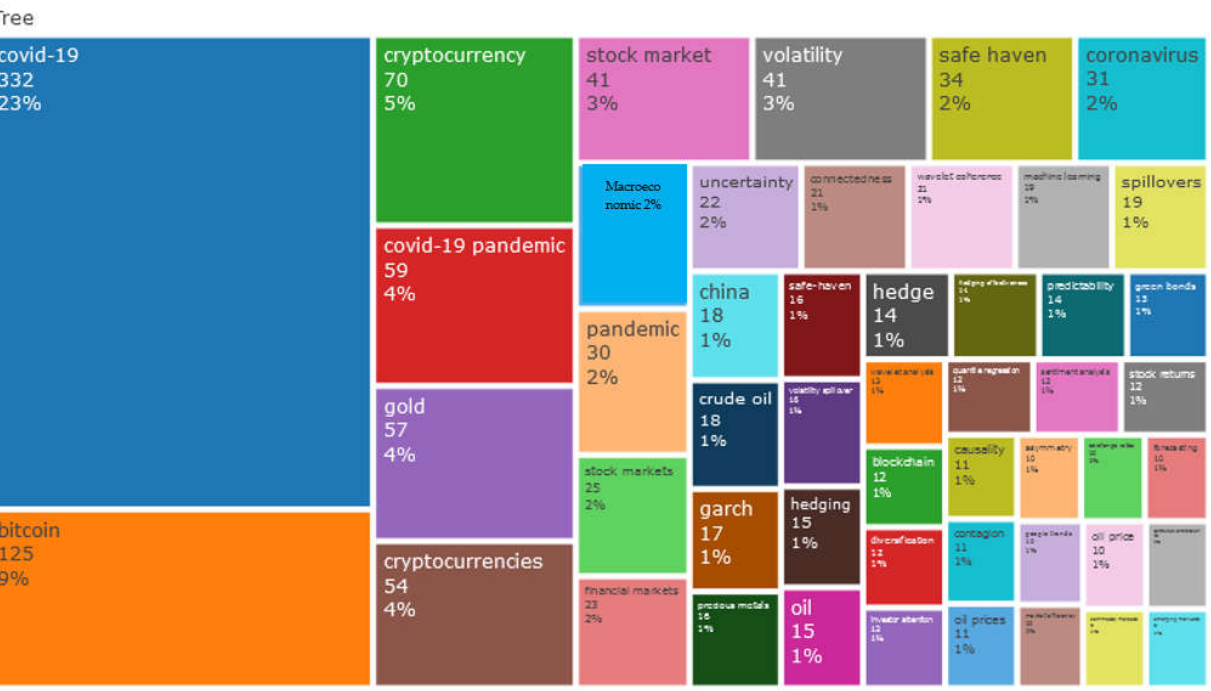
Figure 1. Tree map. Source: Biblioshony/Scopus.